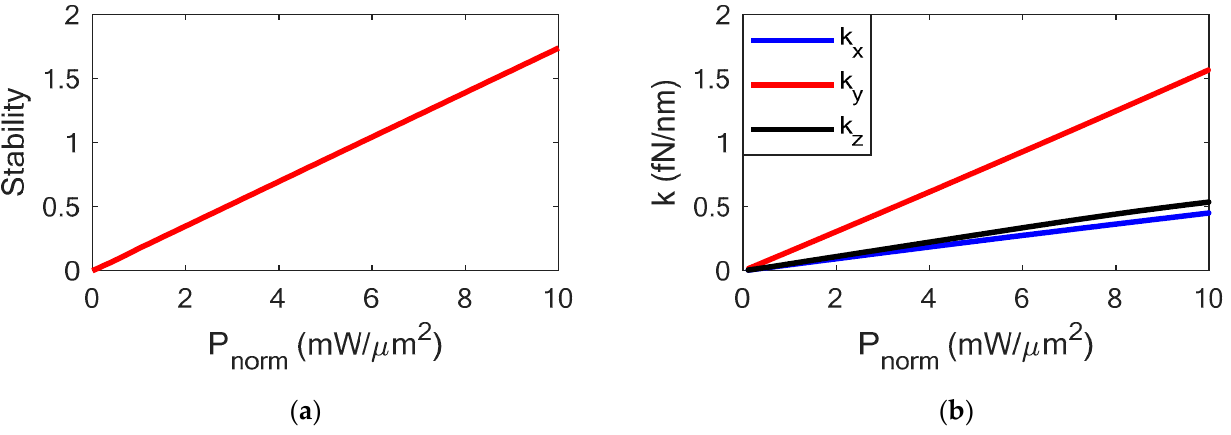
Figure 6. Stability ( a ) and stiffness k ( b ) of the trapping event by varying the input optical power P norm .